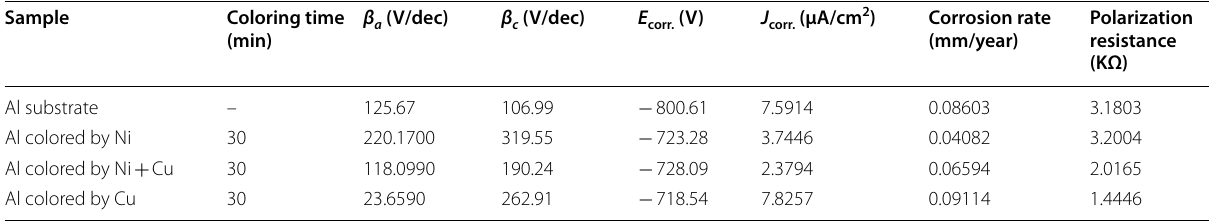
Cu and Cu at constant anodization time +